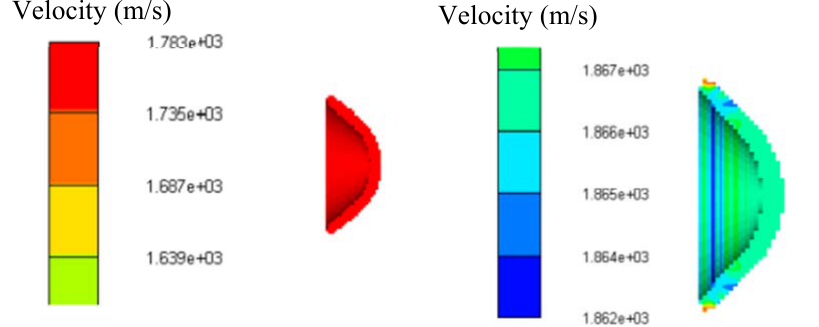
Figure 8. Different penetrator velocities for different metal casing thicknesses (Autodyn) [8]